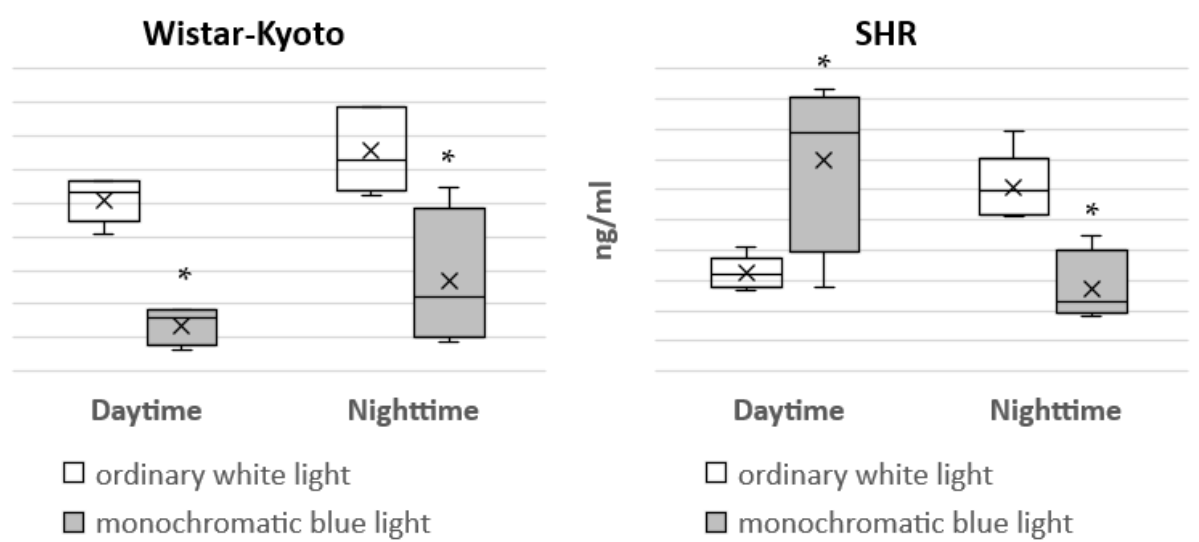
Figure 9. Urinary concentration of aMT6s in Wistar–Kyoto and SHR rats under the standard light pattern (12 h:12 h) with ordinary white light and monochromatic blue light. *— p ≤ 0.05.